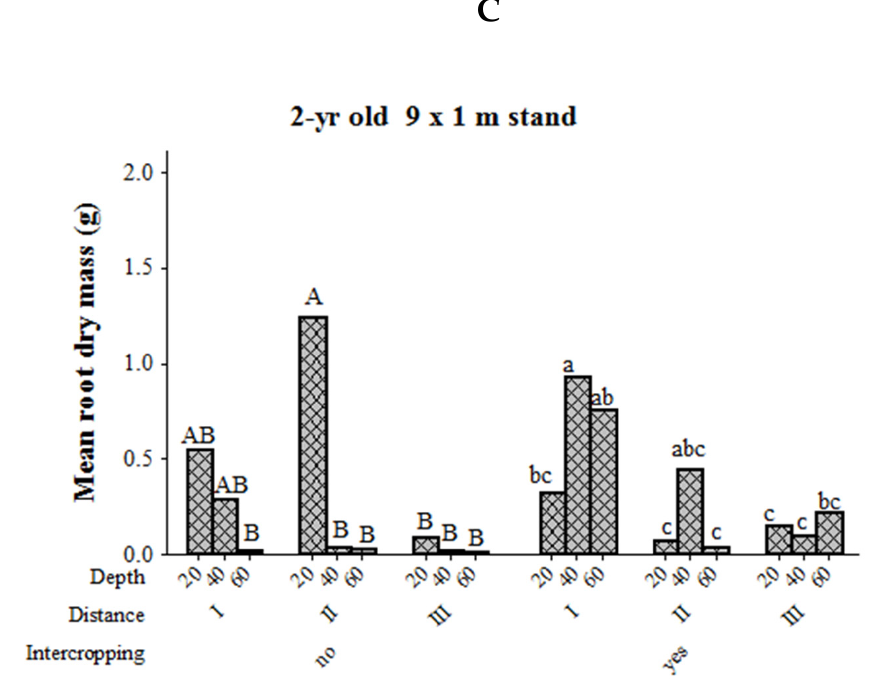
Figure 5. Mean root dry mass (g) of E. camaldulensis trees at different soil depths in stands with or without intercropping, and at different distances from the tree base. Bars with the same lower case letter (s) are not significantly different among intercropped stands at different distance from the tree base and soil depth at 5% probability. Bars followed by different uppercase letter are significantly different among distances from the tree base and soil depth within monoculture stands. 5 m × 2 m stand ( A ), 7 years old 9 m × 1 m stand ( B ), 2 years old 9 m × 1 m stand ( C ).